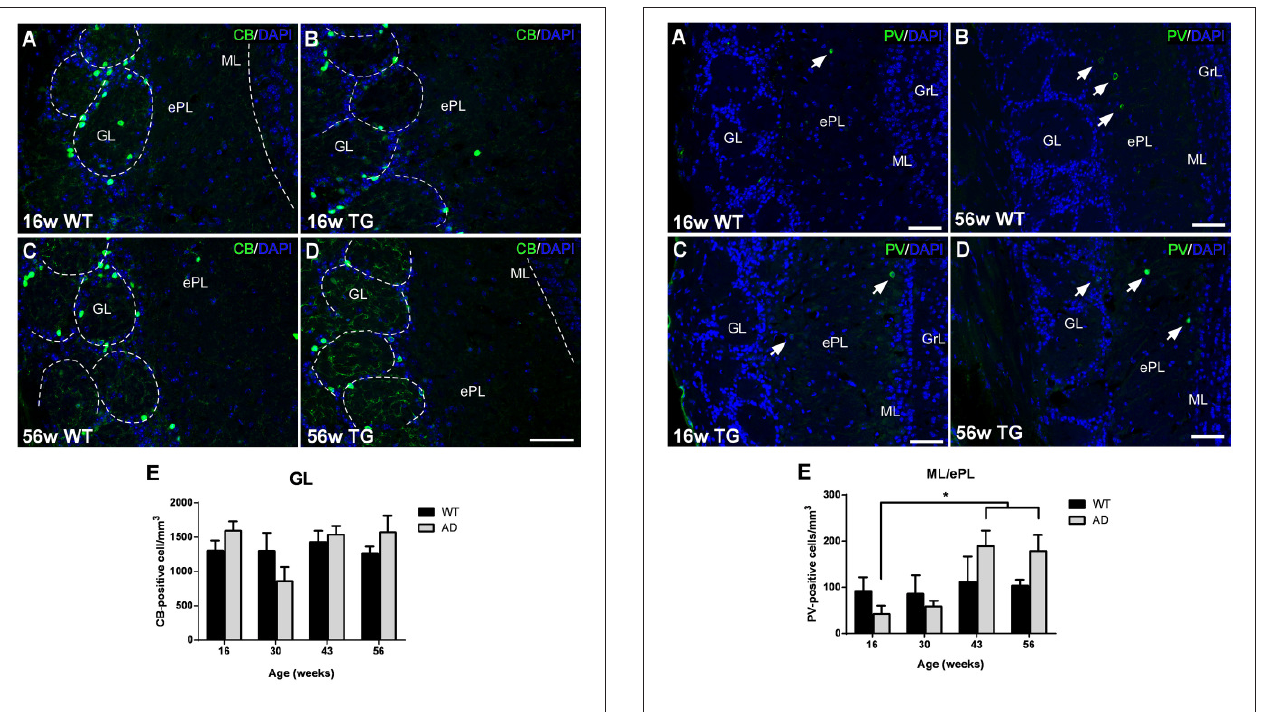
FIGURE 3 | Vulnerability analysis of calbindin-expressing cells in the olfactory bulb. (A–D), Confocal images showing calbindin-positive cells in the glomerular layer of control and transgenic animals at different ages. (E) , graphics illustrating the estimation of calbindin-positive cells/mm 3 in control and transgenic animals in the glomerular layer with aging. Calibration bar, 50 µ m.